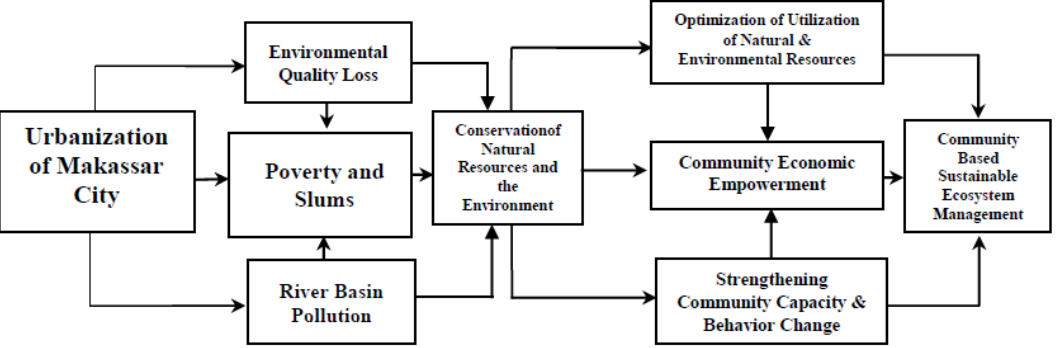
Figure 1. Conceptual Framework Natural Resource Conservation. Based on Community Economic Empowerment. Source: author